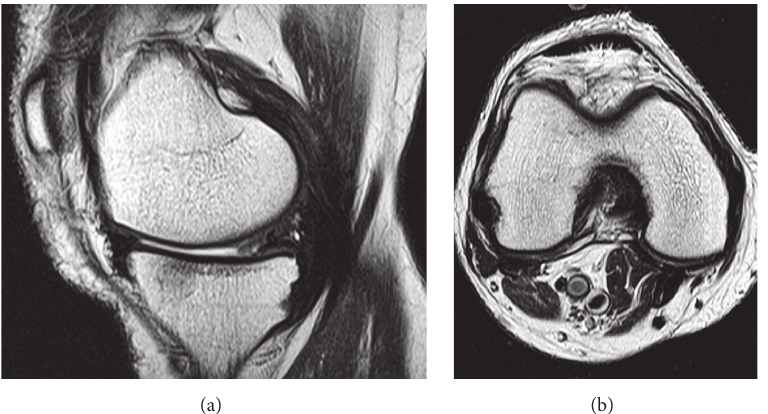
Figure 4: T2-weighted sagittal (a) and axial (b) magnetic resonance images taken 1 year postoperatively. No evidence of the popliteal cyst is